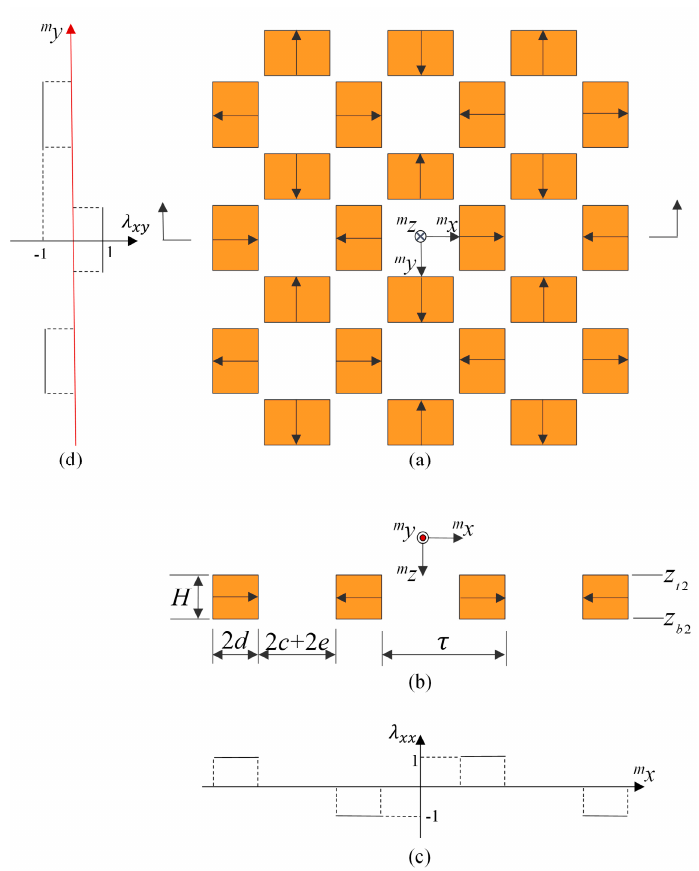
Figure A1. The distribution factors of the residual magnetism amplitude. ( a ) Top view of the magnet array; ( b ) cut-view of the magnet array; ( c ) λ xx ; ( d ) λ xy .